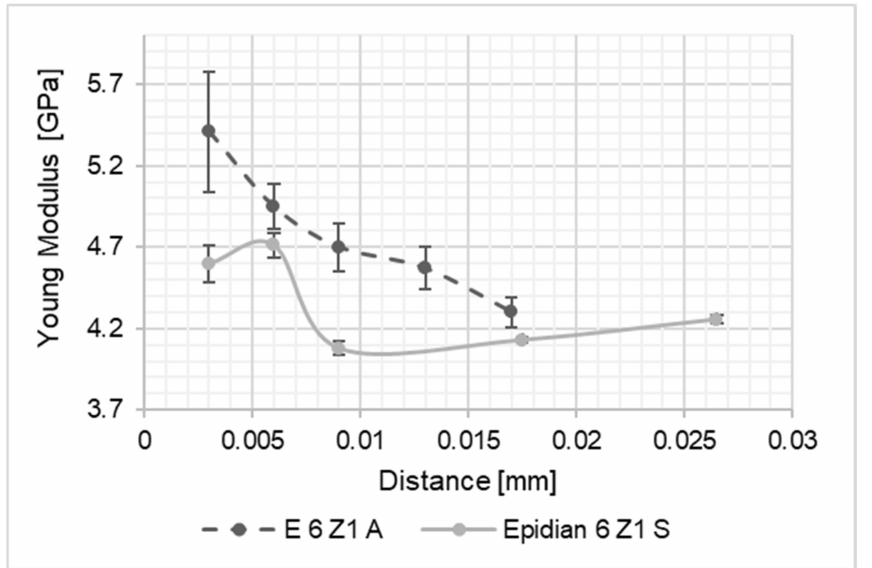
Figure 9. Comparison of Young’s modulus values for the Epidian 6/Z1 joint bonding: A—aluminium alloy sheets; S—stainless steel sheets, as